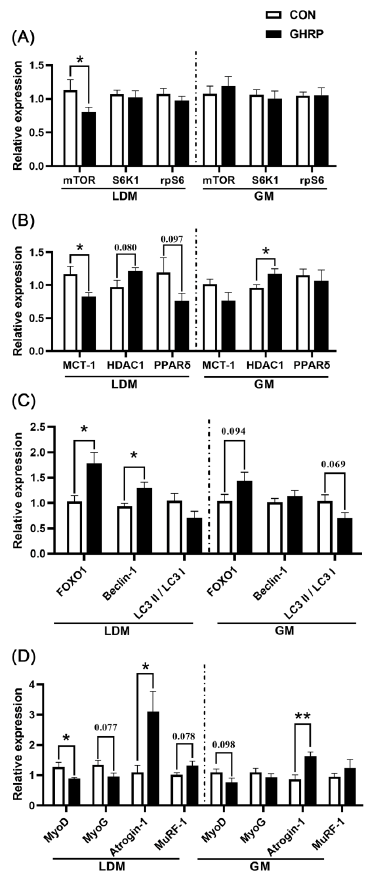
Figure 6. The mRNA expression of genes related to protein deposition in the control group (CON) and ghrelin antagonist group (GHRP). ( A ) Relative expression levels of genes related to protein synthesis in mTOR pathway (mTOR, S6K1, rpS6) in longissimus dorsi muscles and gastrocnemius muscles. ( B ) The expression of genes MCT-1, HDAC1 and PPAR- δ in longissimus dorsi muscles and gastrocnemius muscles. ( C ) The expression of genes FOXO1 and Beclin-1 and LC3 II to LC3 I ratio in longissimus dorsi muscle and gastrocnemius muscle. ( D ) The expression of genes MyoD, MyoG, Atroigin-1 and MuRF-1 in longissimus dorsi muscles and gastrocnemius muscles. Values are means ± SEMs; n = 6. * p < 0.05 versus control group; ** p < 0.01 versus control group. LDM: longissimus dorsi muscles; GM: gastrocnemius